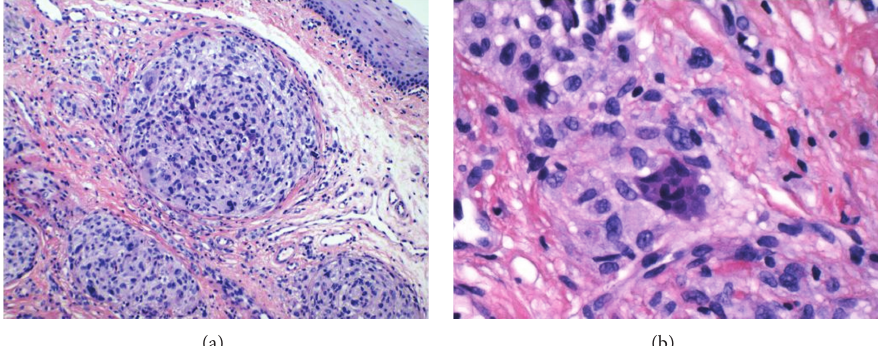
Figure 2: H&E stain, low (a) and high (b) power microscopic views. Intramucosal micronodules, shaped in a characteristic whorled pattern with concentric growth. Cells are epithelioid to spindle shaped with mild cytologic atypia.